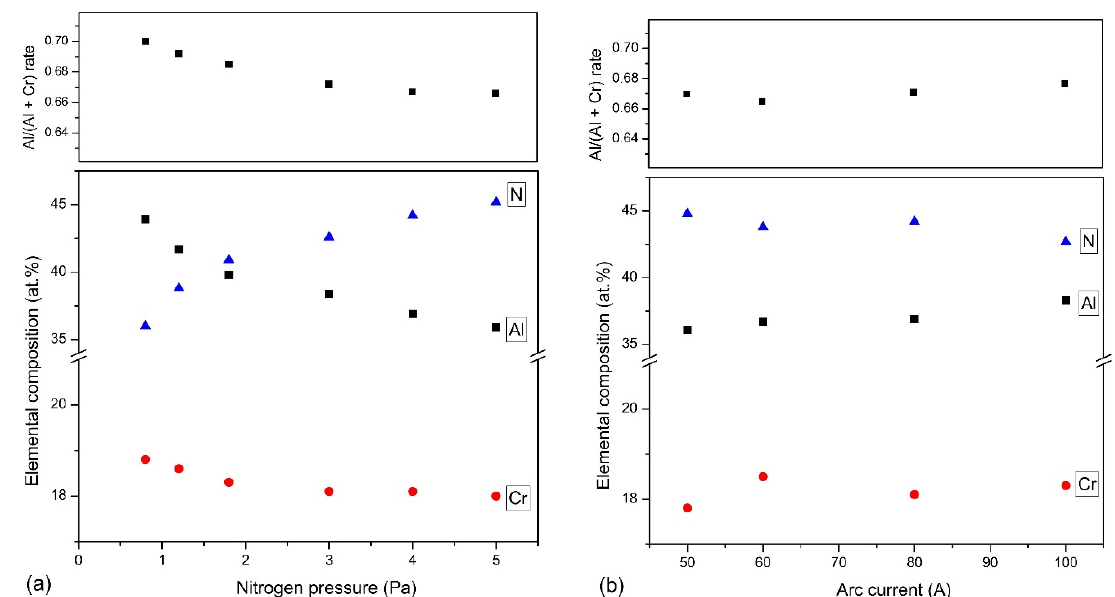
Figure 2. Elemental composition and Al/(Al + Cr) ratio of the coatings deposited at: ( a ) various nitrogen pressure, ( b ) various arc current.